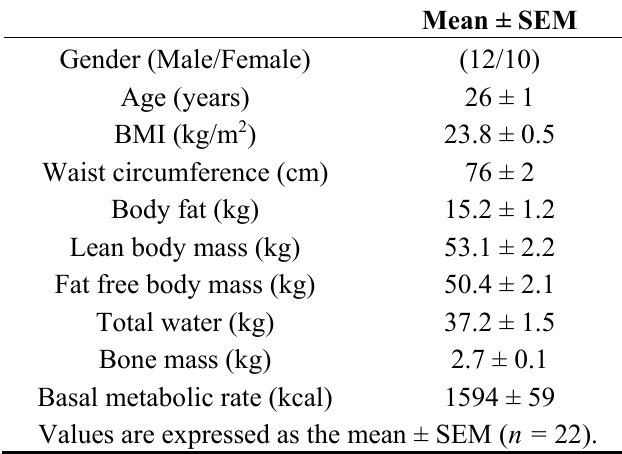
Table 2. Baseline demographic and anthropometric characteristics of the